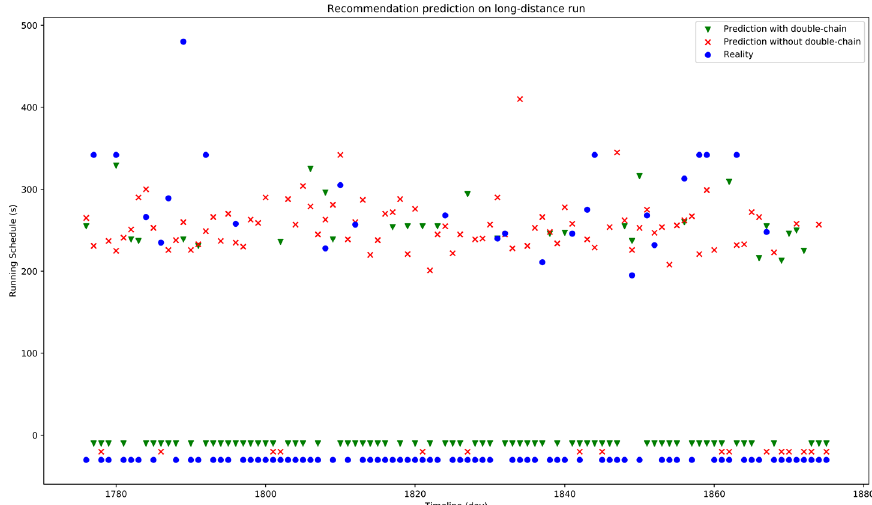
Figure 4. Recommendation prediction on long-distance running. The values below 0 mean that students did not run or were not scheduled to run at that day.